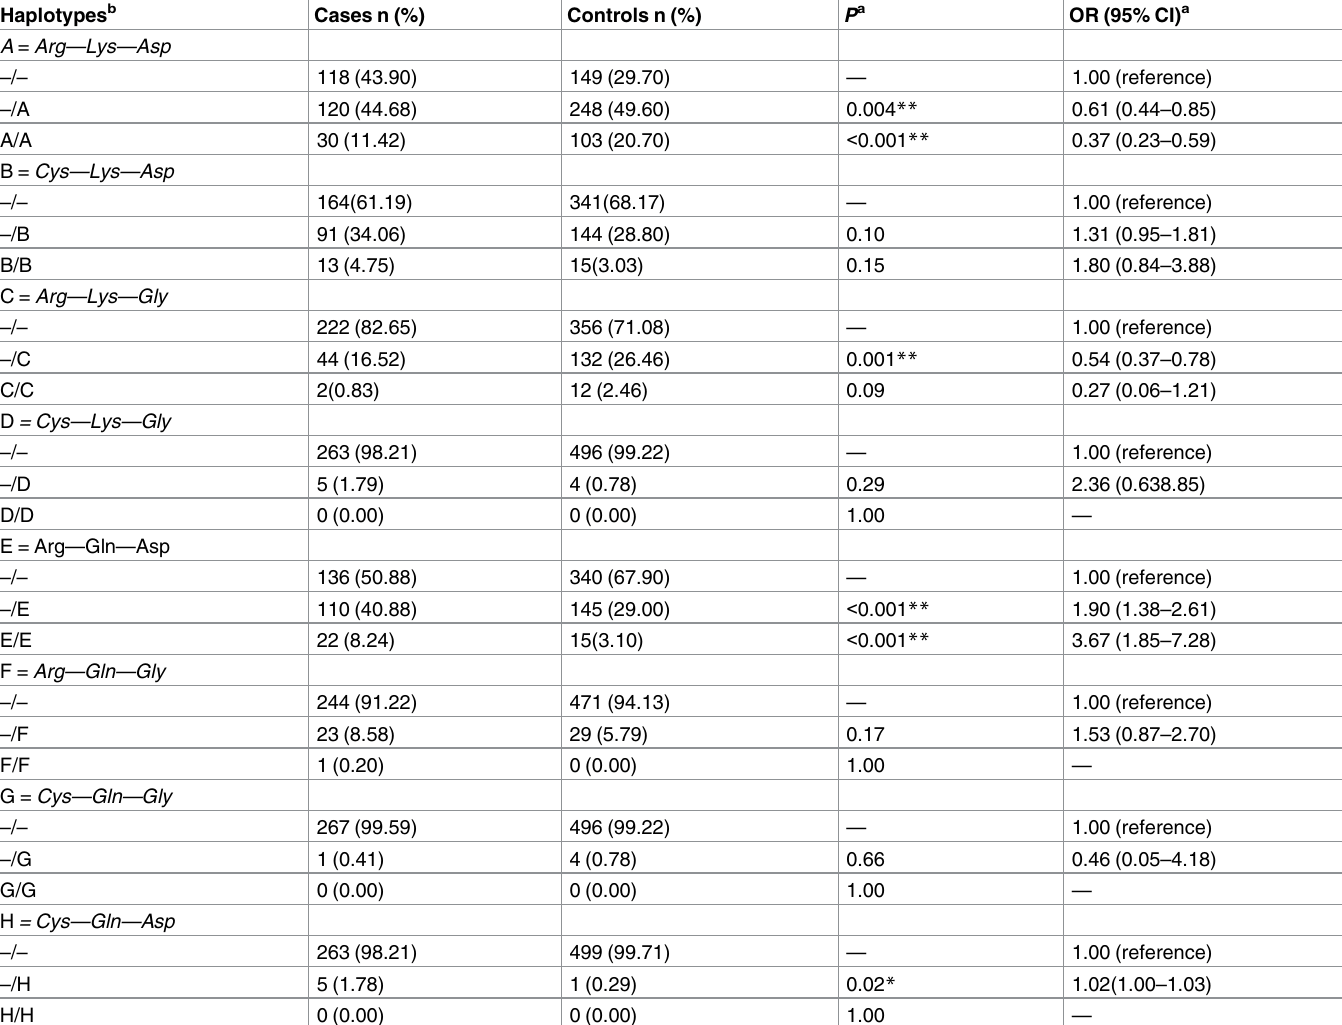
Table 6. Association of haplotypes with polymorphisms of LMP2, LMP7 and TAP1-2 with risk of ESCC in the Kazakh population. Haplotypes